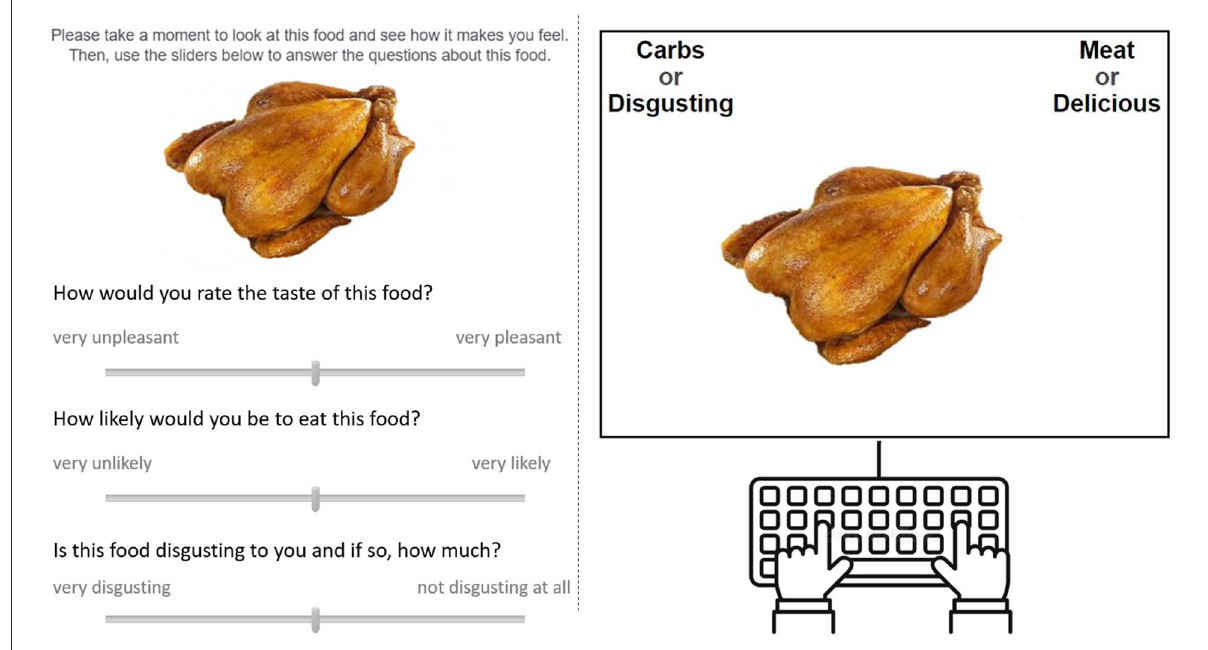
FIGURE1 Example trials from the VAS meat/carb rating task (left) and the IAT (right). In both tasks, the same set of images was used (six of meat and six of carbohydrate rich